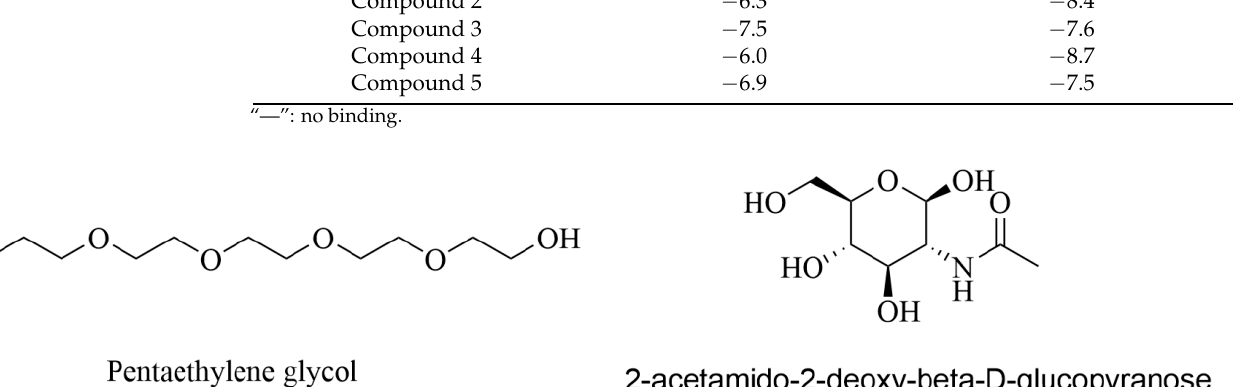
Figure 5. Chemical structure of AchE and BuchE native ligands .